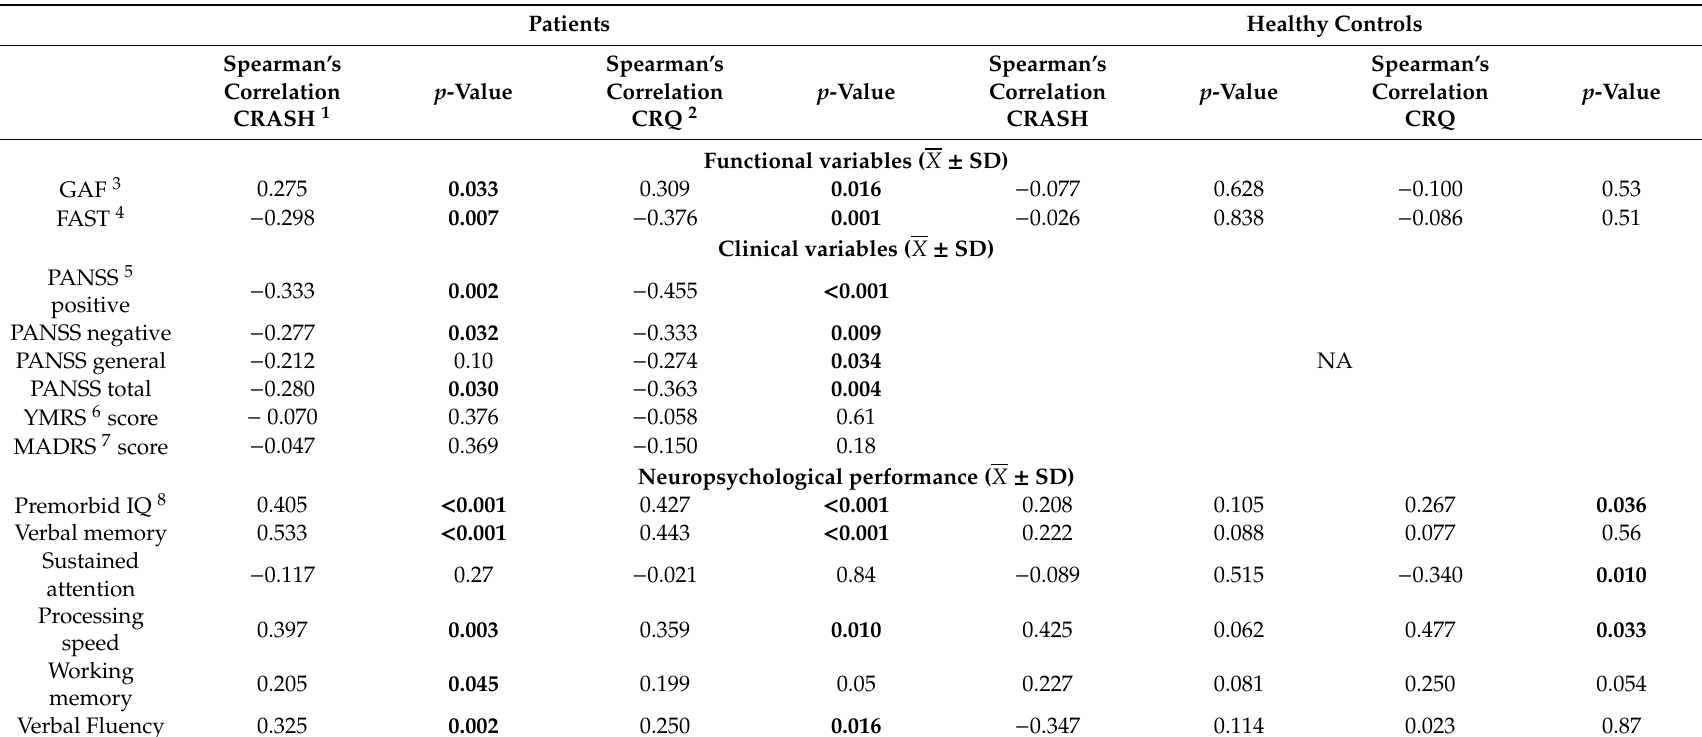
Table 4. Spearman’s correlation analyses of CRASH and CRQ with functional, clinical, and cognitive